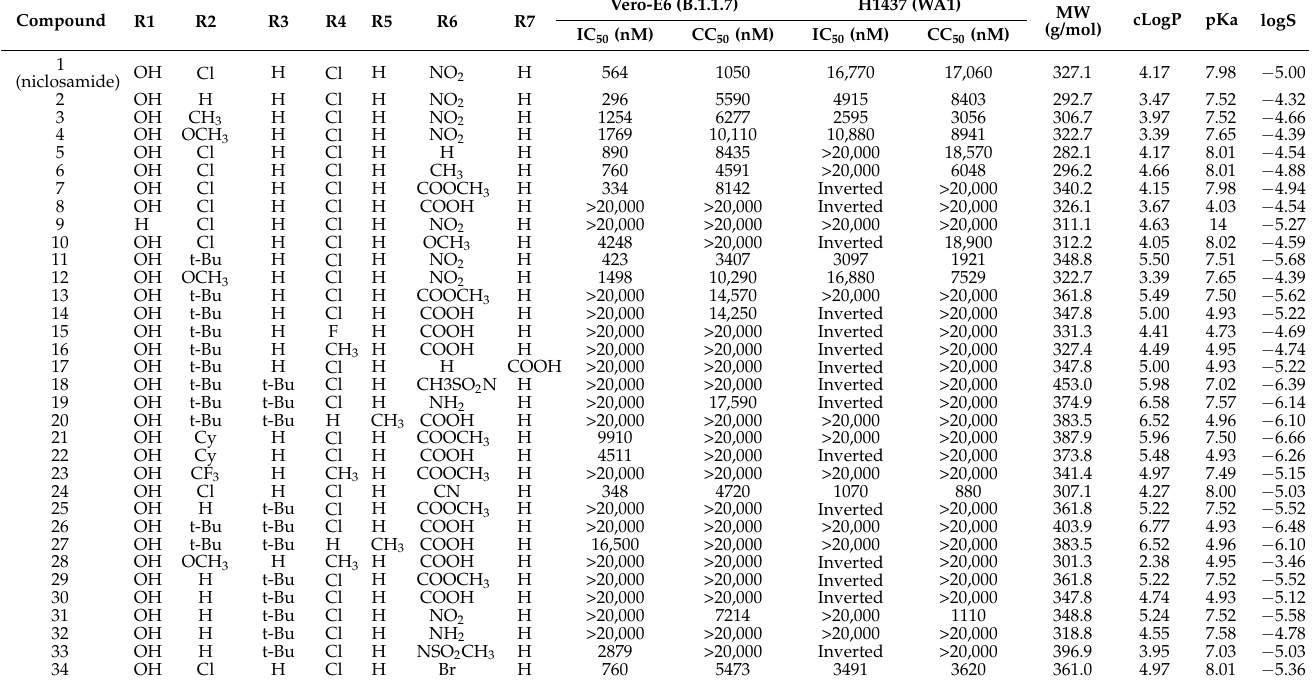
Table 1. SAR table for niclosamide analogs. IC50 and CC50 values for VeroE6 (SARS-CoV-2 B.1.1.7 variant) and H1437 (SARS-CoV-2 WA1 variant). IC50 and CC50 values were determined using 10-point 2-fold dilution series experiments ( n = 3) for each compound. Physical properties including molecular weight (MW), cLogP, pKa, and logS were calculated using MOE and included in the table for each compound. Compounds that have efficacy against both cell lines are highlighted in